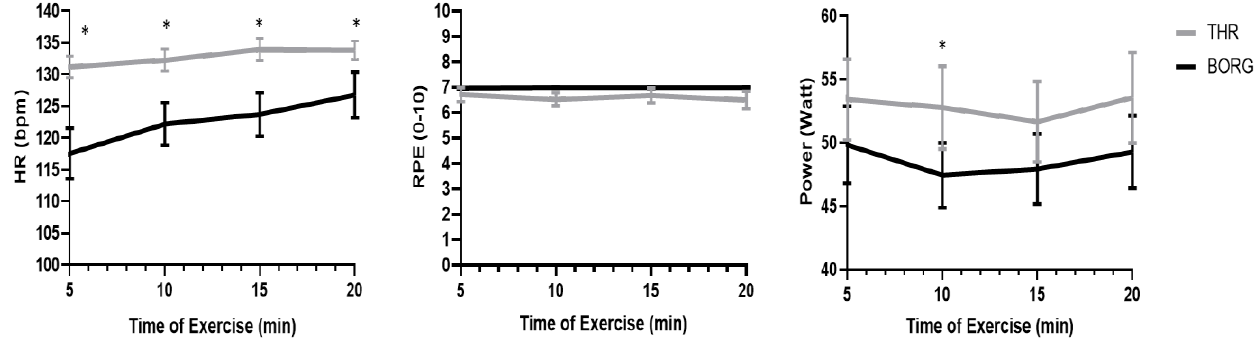
Figure 1. HR, RPE, and Power during the 20 min of exercise for both protocols. HR (left panel), RPE (middle), and power (right panel) variables during the exercise as recorded every 5 min on THR